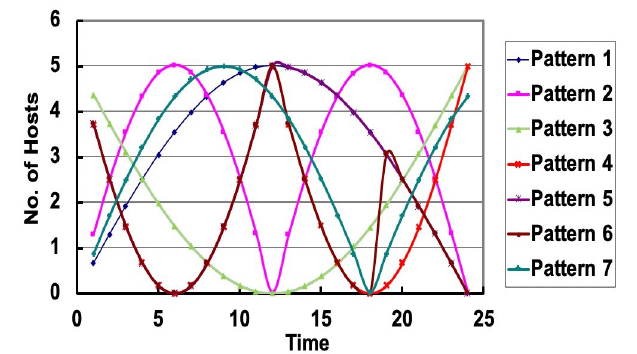
Figure 2. Patterns of numbers of the associate hosts, supposing that the maximum number of associated hosts is